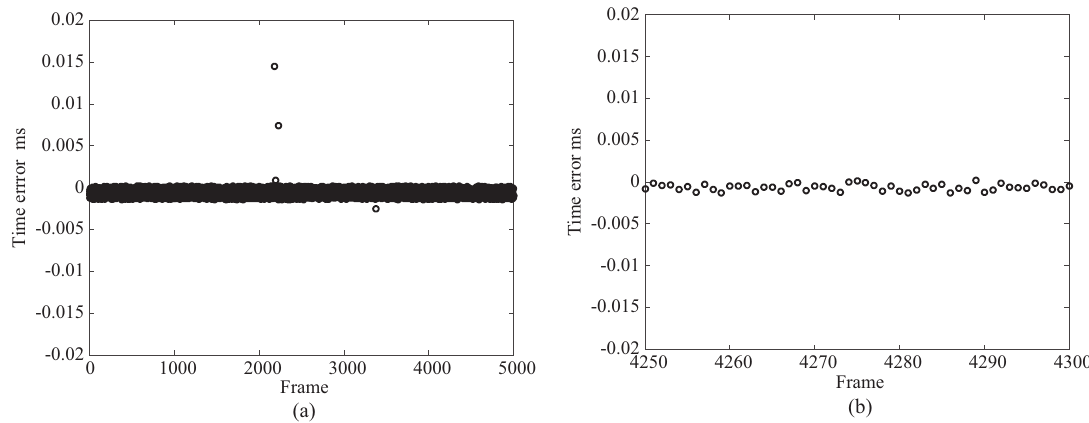
Figure 5. Time error for data-acquisition in Experiment 1: ( a ) shows overall result and ( b ) shows enlarged result. Adapted from [14].